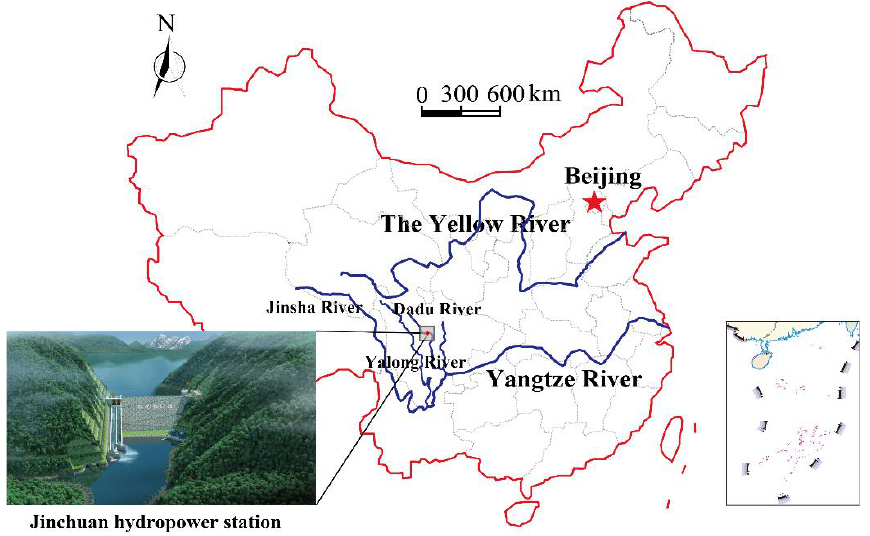
Figure 1. Location of the Jinchuan hydropower station.